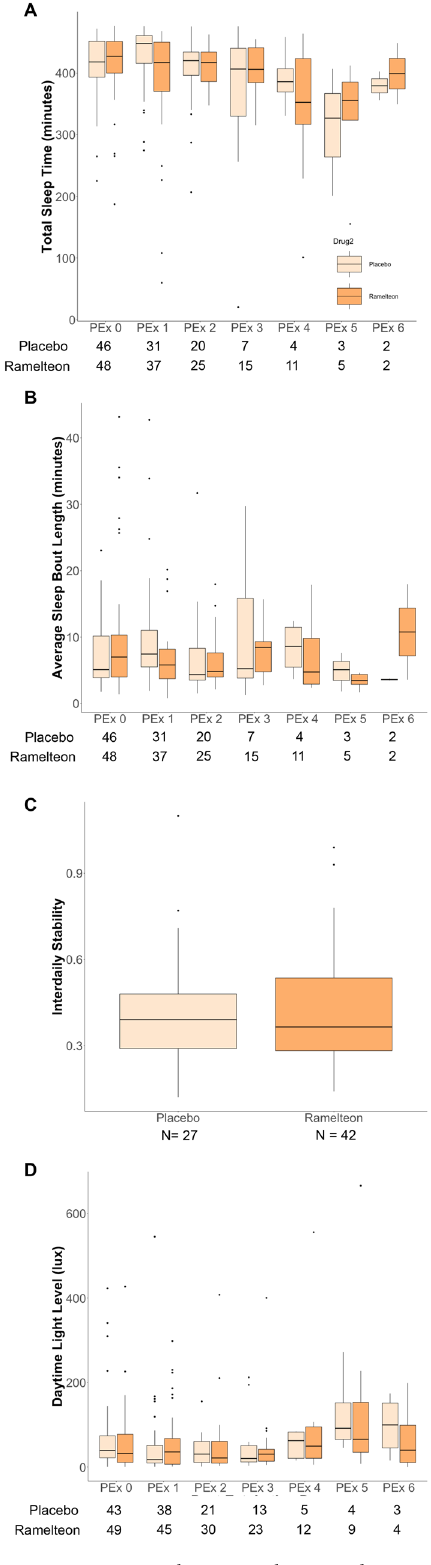
Figure 2. Actigraphy metrics between drug groups. ( A ) Total Sleep Time. Boxplots of total sleep time over the nighttime period between groups based on post-extubation day. ( B ) Sleep Bout Length. Boxplots of average sleep bout length over the nighttime period between groups based on post-extubation day. ( C ) Interdaily Stability. Boxplots of interdaily stability between groups. ( D ) Daytime light exposure. Boxplots of lux levels over the daytime